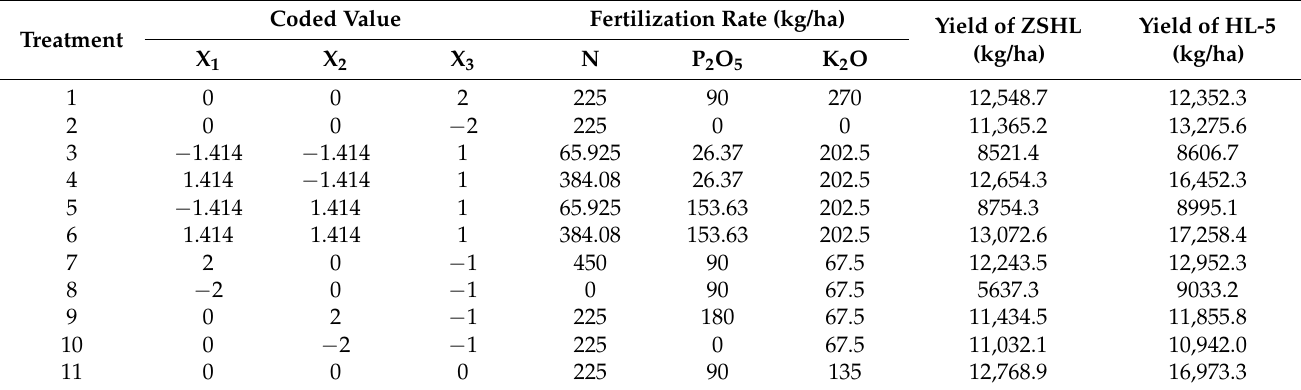
Table 1. The yields of broccoli under various fertilization treatments.